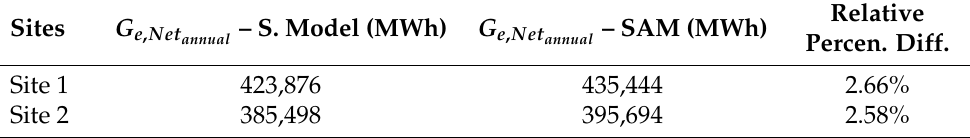
Table 9. Relative percentage difference of the net electric power generation between simulations. Sites